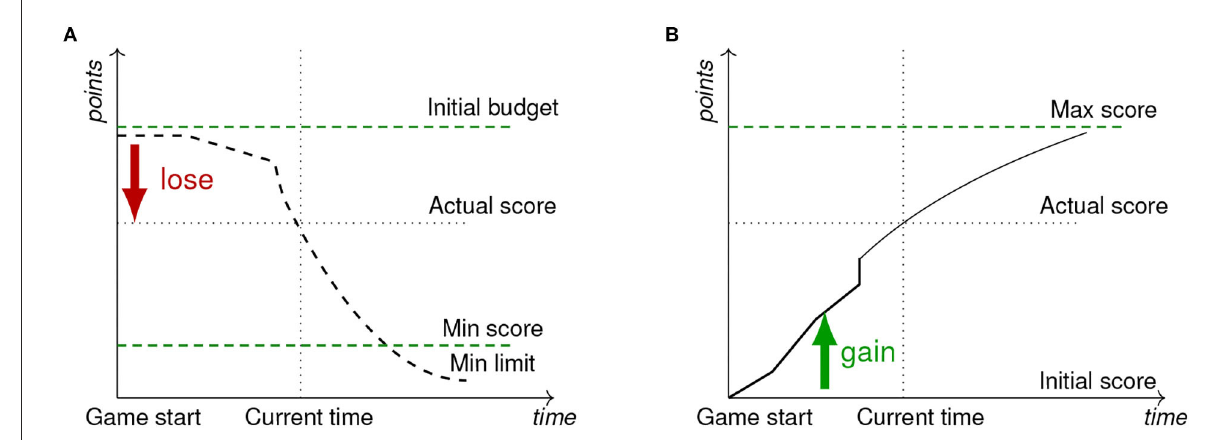
FIGURE5 The increasing and decreasing score functions curves. (A) A decreasing curve. (B) An increasing